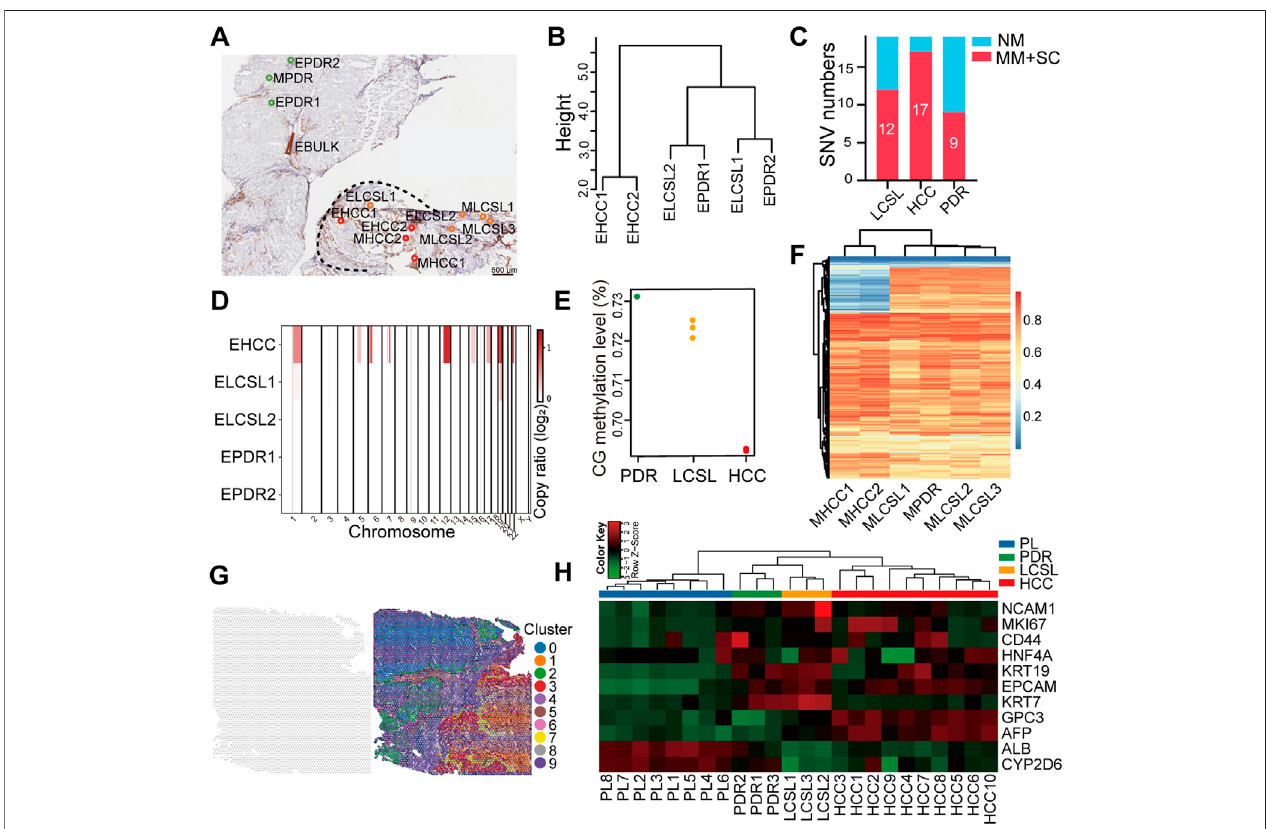
FIGURE5| Only minor geneticand epigeneticchangesin HCCLCSL cells. (A) Locations and namesofthesamplesused forCIL-seq. Differenttypes ofcells were captured by LCM from a frozen section of specimen P7 after the section was immunostained with anti-EpCAM. The dotted lines in the fi gure indicate the boundaries between the tumor and the paratumor, which were determined by IHC staining and tissue/cell morphology under microscope. (B) SNV cluster analysis of the different types of cell samples. (C) The number of missense mutations (MM) and stop codon changes (SC) identi fi ed in different cell types. NM, no mutation. (D) Ampli fi ed CNVs in different cell samples. One sample (EHCC2) with low WES coverage is not shown. (E) The global DNA methylation levels of six different types of cells. Each dot representsonesample. (F) DNAmethylationpro fi lesofsixcellsamples.Eachrowisa300-bpwindowthatiscoveredbyatleastthreebases(coverage ≥ 3)inallsamples. (G) Unbiased clustering of all ST spots of P7 tissues. K-Means cluster analysis, K = 10. (H) Cluster analysis of the expression patterns of the selected genes in different spots, as shown in Supplementary Figure S7D .